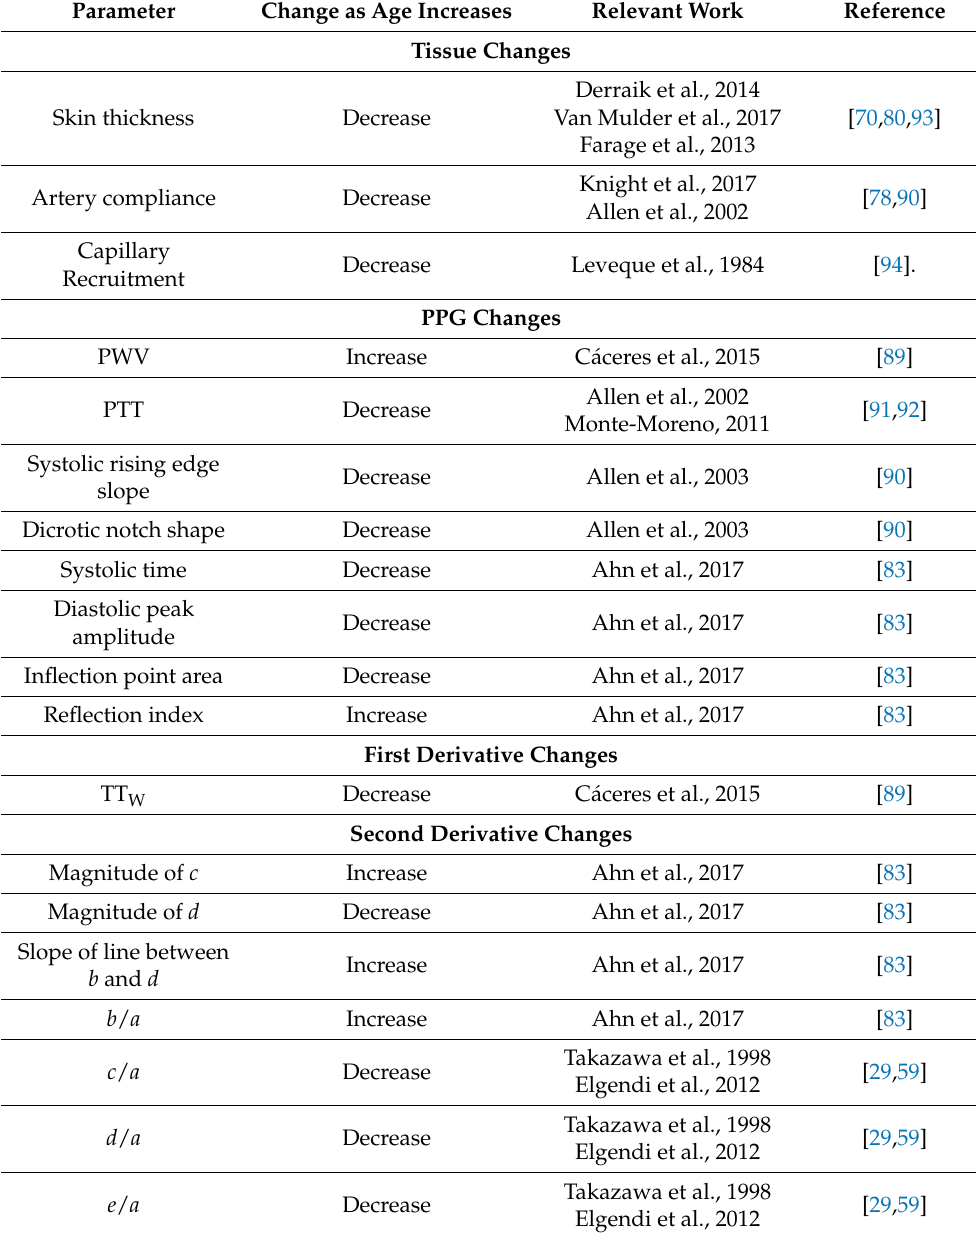
Table 3. Age-induced changes on